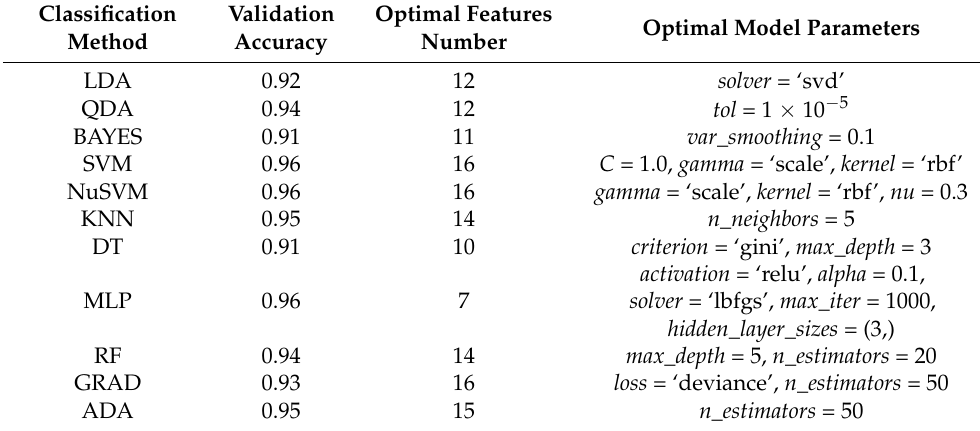
C = 1.0, gamma = ‘scale’, kernel = ‘rbf’ 0.96 16 gamma = ‘scale’, kernel = ‘rbf’, nu =